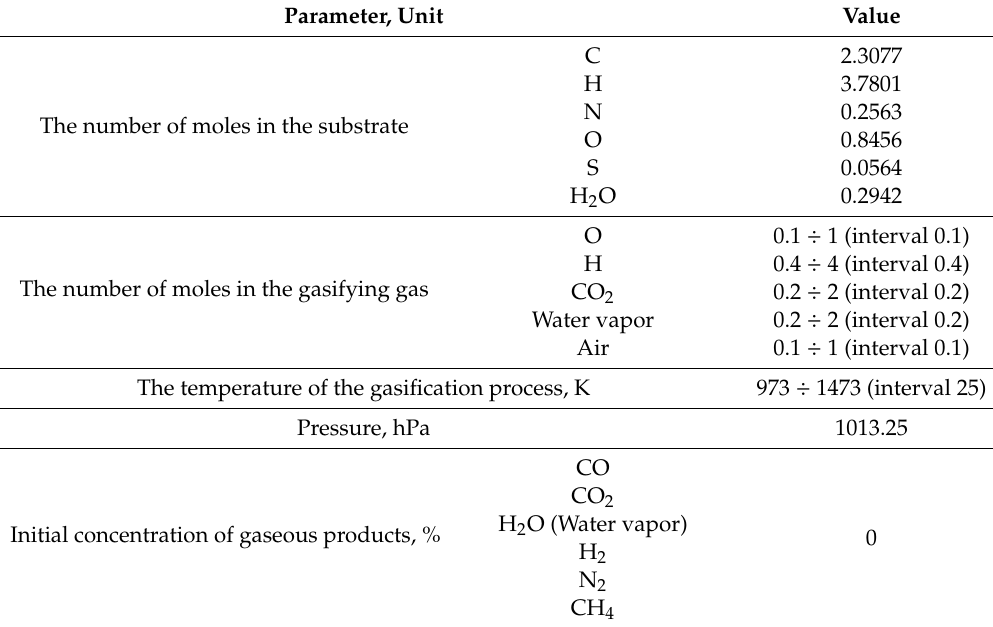
Table 3. Data used to simulate the sewage sludge